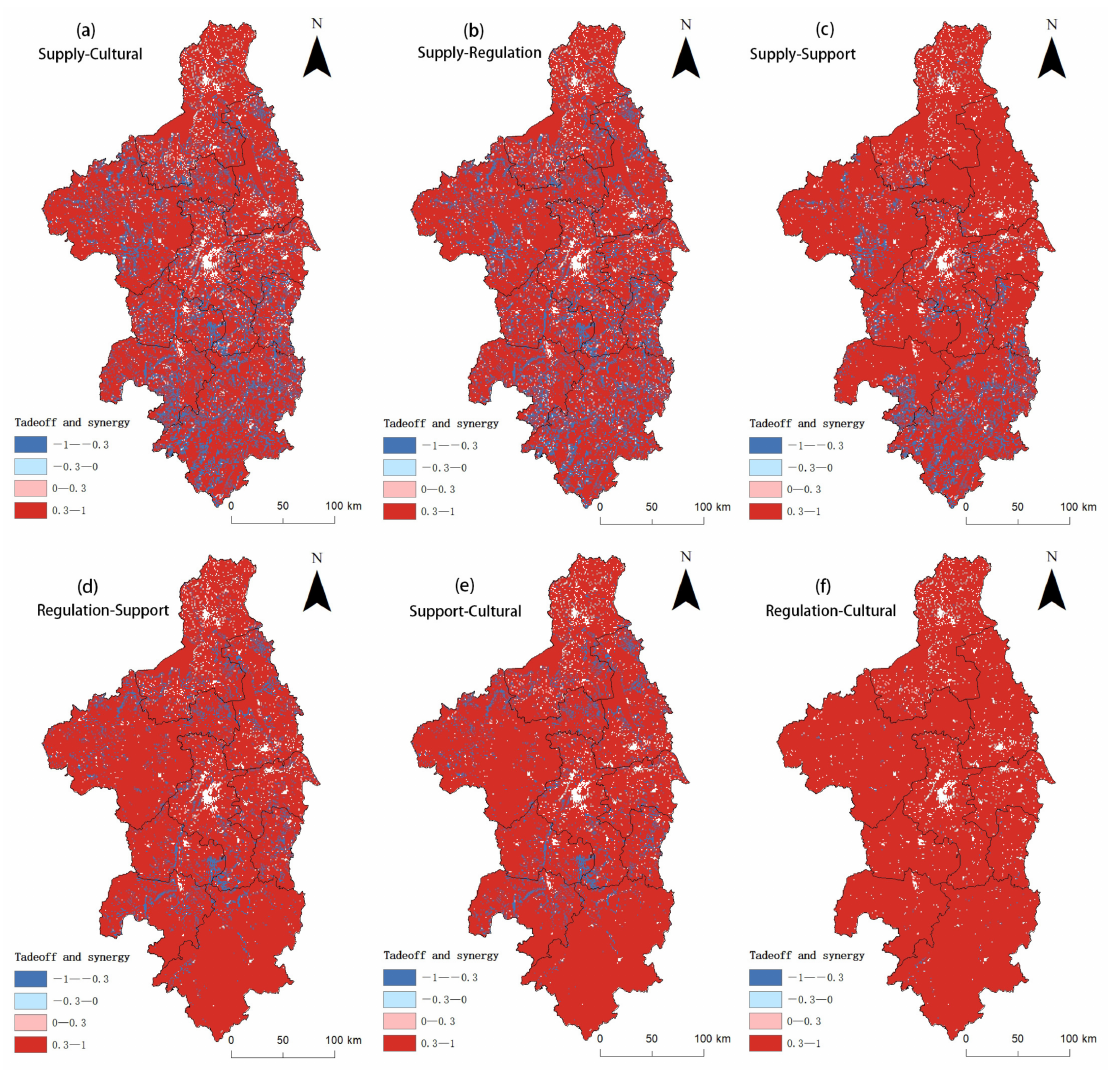
Figure 7. The trade-offs and synergies between ( a ) supply service value and cultural service value, ( b ) supply service value and regulation service value, ( c ) supply service value and support service value, ( d ) regulation service value and support service value, ( e ) support service value and cultural service value, and ( f ) regulation service value and cultural service